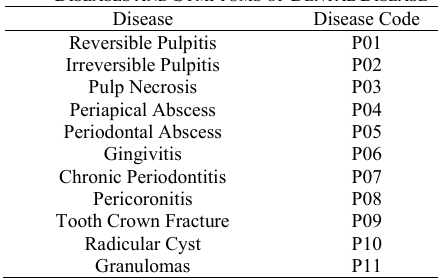
TABLE 2 D ISEASES AND S YMPTOMS OF D ENTAL D ISEASE